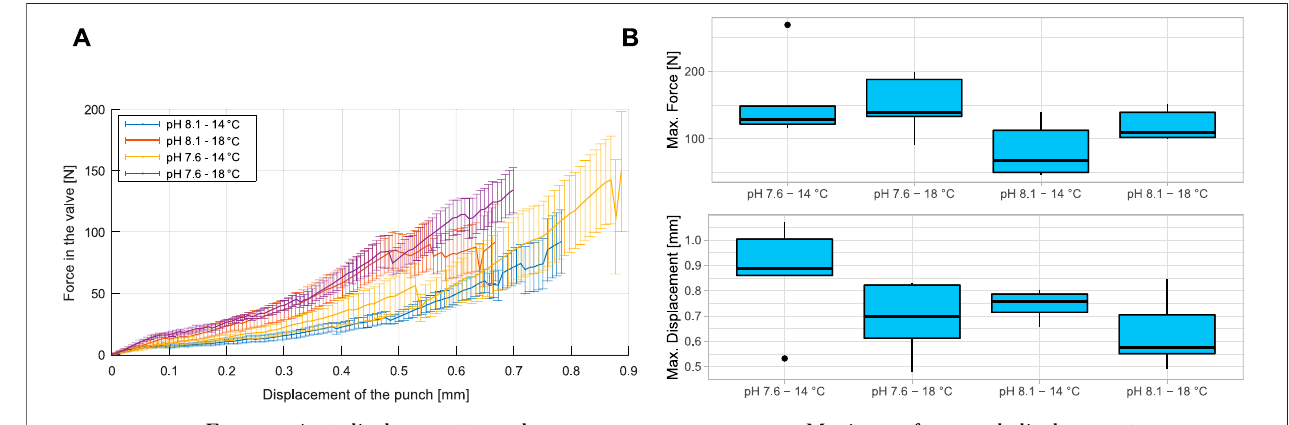
FIGURE7| Flexocompressiontestresults: (A) showsthebehaviorofcompleteshellsina fl exo-compressiontest.Itisshownattheapplicationofforceonthevalve and displacementofthepunch(vertical)at thecusp oftheshell. (B) shows thecomparison ofthebehaviorofshells subjectedto fl exo-compressiontests. Thetop graph shows the maximum force applied to the shell (N), and the bottom graph shows the displacement of the punch (mm) before the fracture. ( C ): extreme values of the distribution.